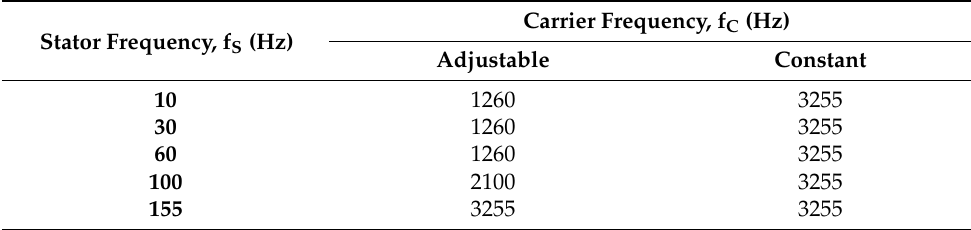
Table 4. Minimum values of carrier frequency against stator frequency for the operating characteris- tics in Figure 2 for the traditional design of Si-IGBT-based converters.